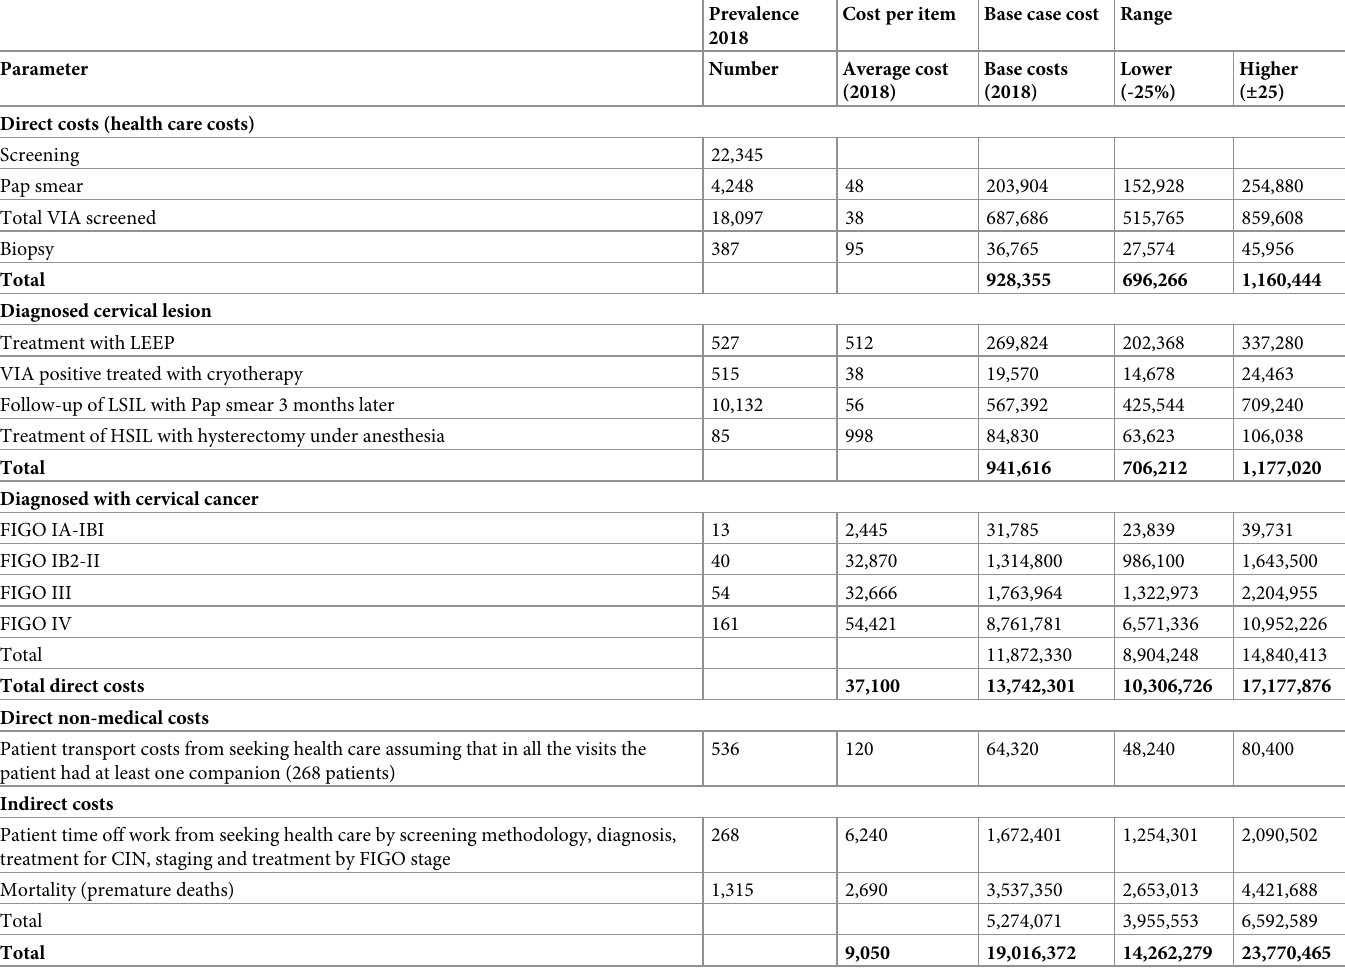
Table 9. Total annual cost estimation for cervical cancer lesions and invasive cancer (direct, direct non-medical and indirect costs) in